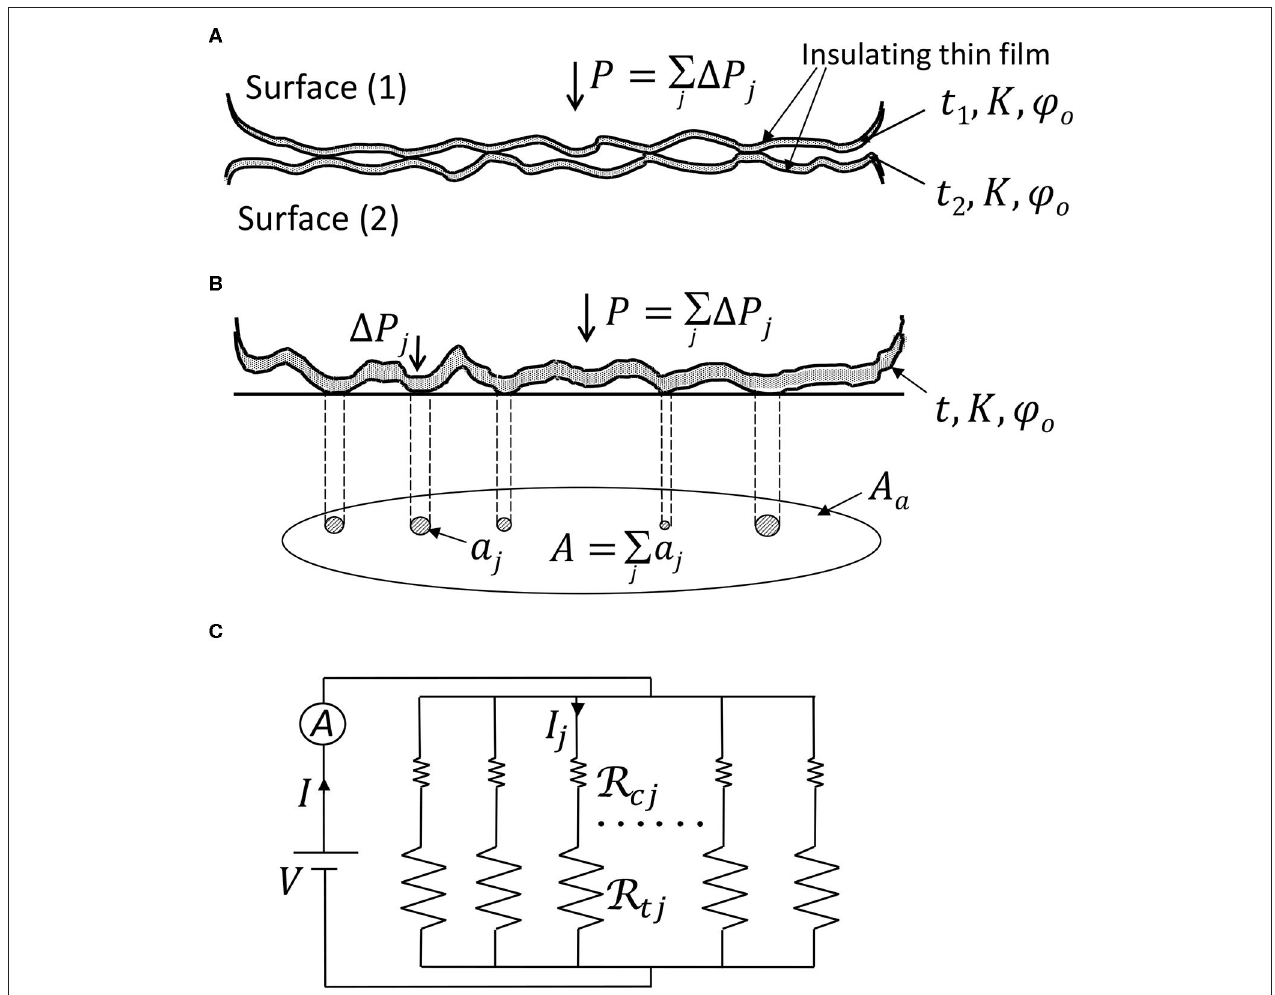
FIGURE 10 | (A) Contact of two rough surfaces separated by an insulating thin film, (B) equivalent contact model of rough surfaces separated by a thin-film insulator, and (C) electrical analog of the contact interface consisting of parallel constriction and tunneling resistances of the asperity microcontacts.